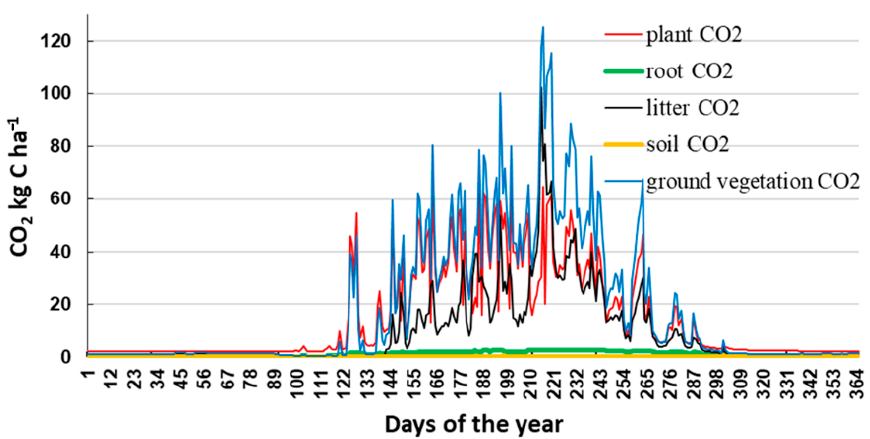
Figure 6. Composite calculated CO 2 fluxes (kg C ha − 1 day − 1 ) of the Great Vasyugan Mire over 2019.